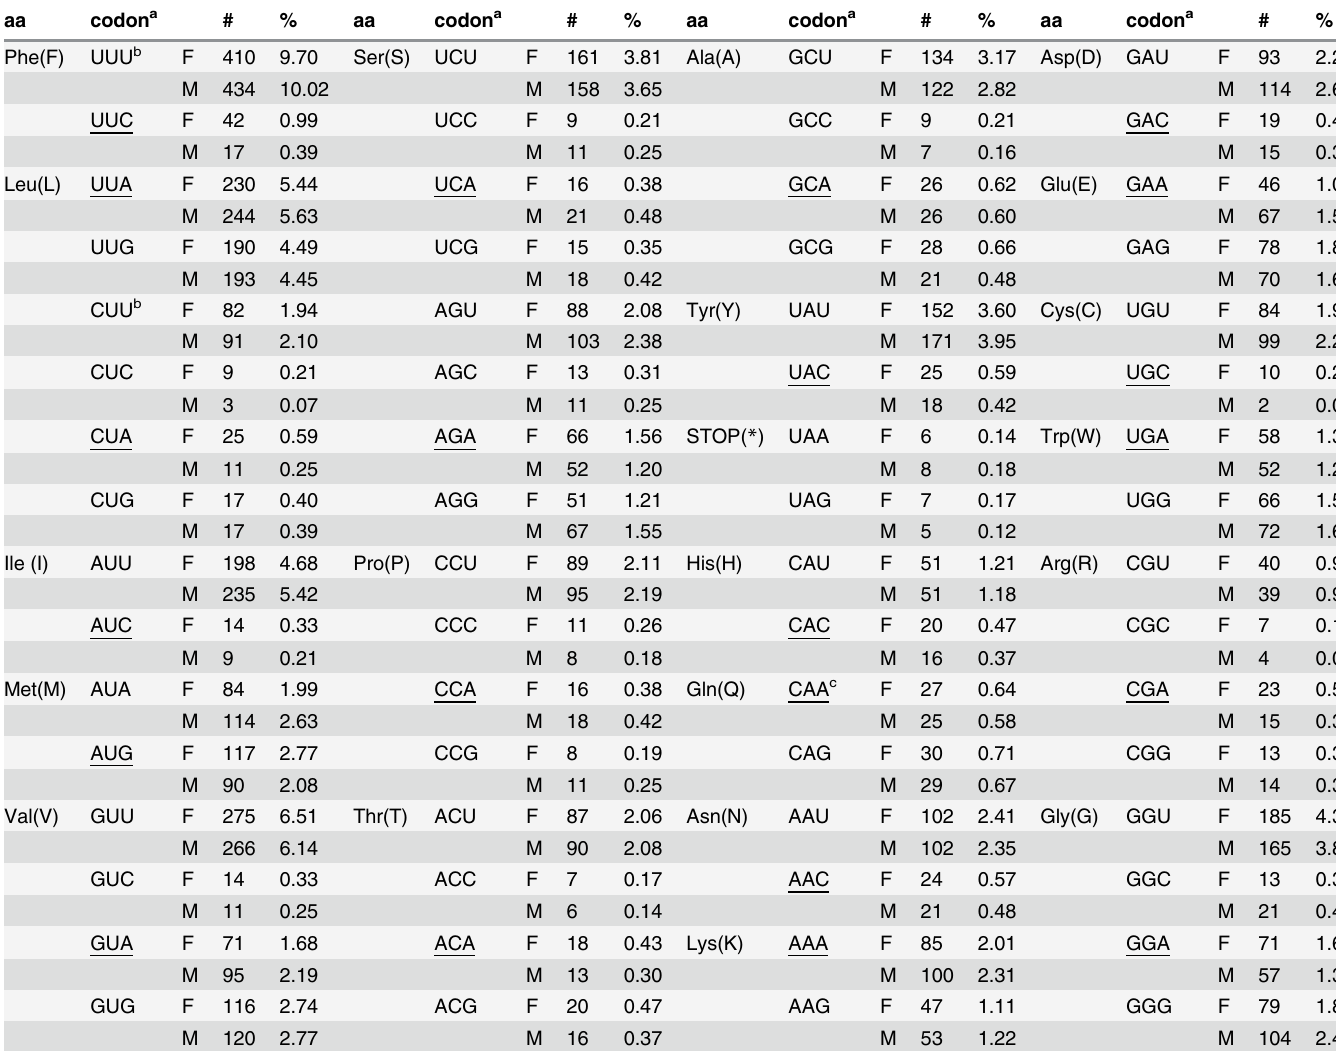
Table 3. Meretrix lamarckii codon count (#) and usage